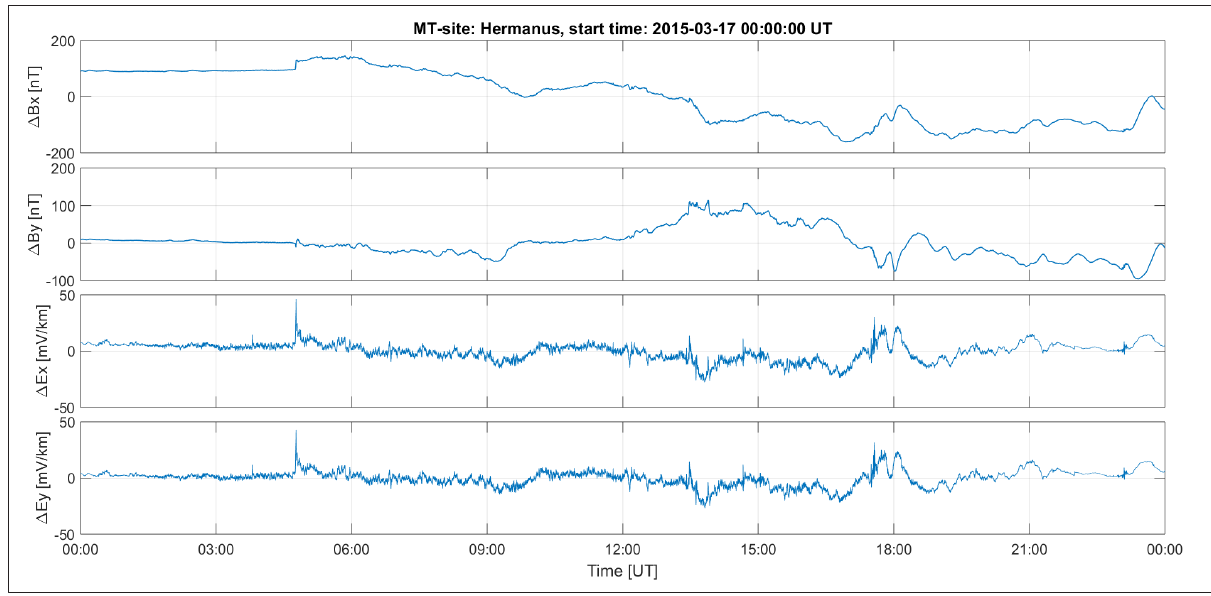
Figure 2: The geomagnetic and geoelectric field recorded by the magnetotelluric (MT) instrument at SANSA Space Science in Hermanus. The data were logged at 1-s intervals, and provide the means to verify models for E-field calculation and also to determine the local surface impedance, which is a key parameter for the estimation of geoelectric fields from magnetometer data, used in the calculation of geomagnetically induced